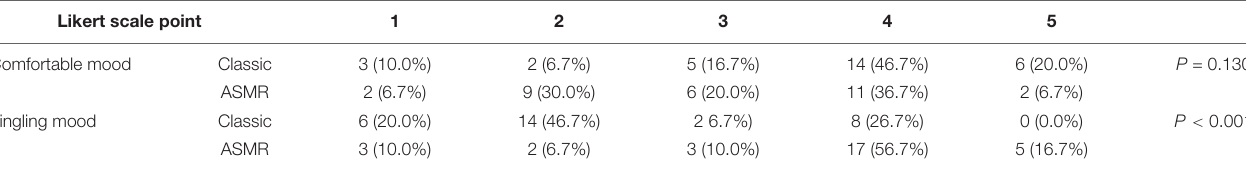
TABLE 2 | Moods while listening to ASMR and classical music. Likert scale